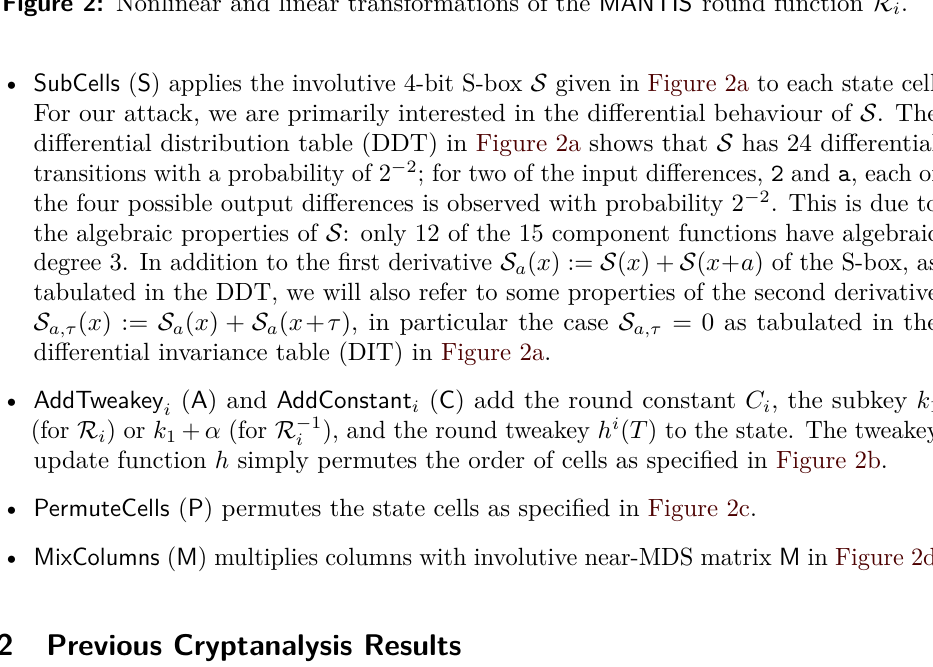
Figure 2: Nonlinear and linear transformations of the MANTIS round function R i